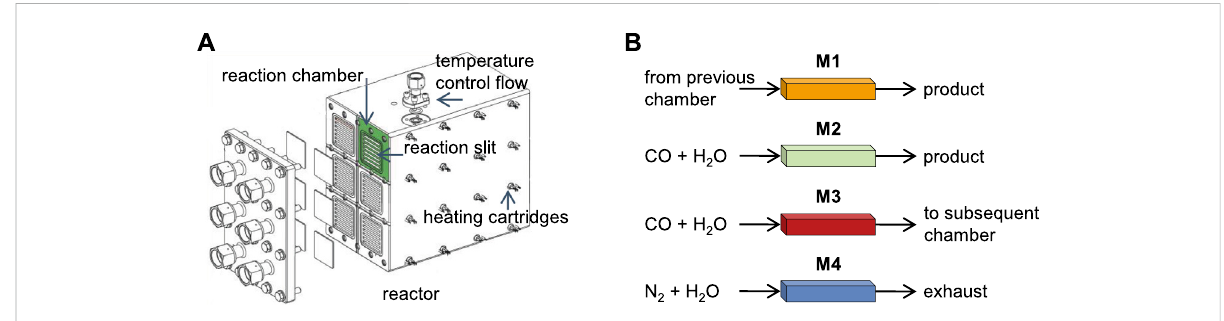
FIGURE 2 (A) Compact SEWGS pilot plant reactor with six individually fed reaction chambers, each consisting of seven rectangular slits. Microchannels and heating cartridges enable advanced temperature control for isothermal operation in the slits. Uniform gas distribution in the slits is realized by means of sintered metal plates. (B) Pilot plant reactor operation modes. M2 stands for reactive adsorption with fresh feed, and M4 for regeneration with purge fl ow. M1 and M3 (both reactive adsorption) occur only in serial con fi guration, when the outlet of one reaction chamber is optionally connected to the inlet of the subsequent reaction chamber Stadler et al.